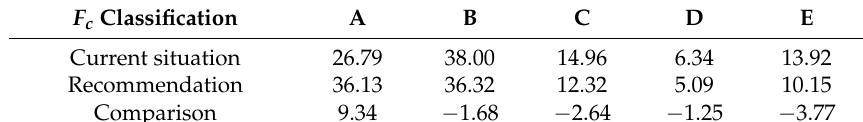
Table 9. Comparison of the F c classification between the recommended program and status quo (unit: %).